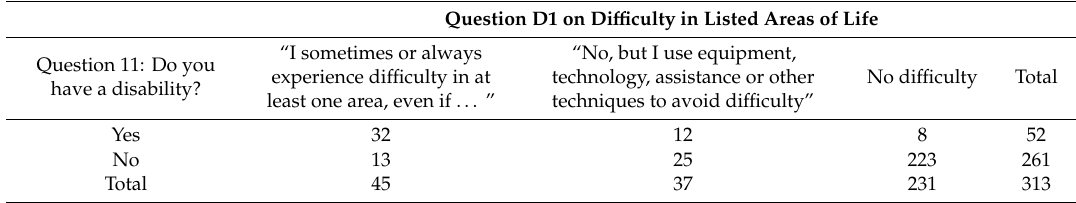
Table 4. Responses to D1 and Q11.